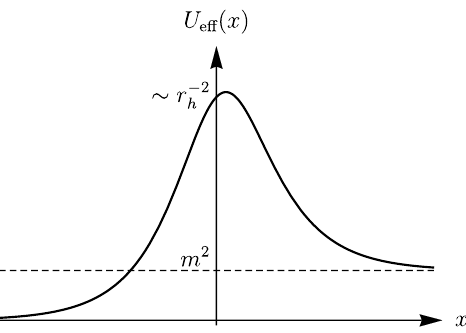
Figure 15. Effective potential for spherically symmetric linear massive modes in the four-dimensional Schwarzschild